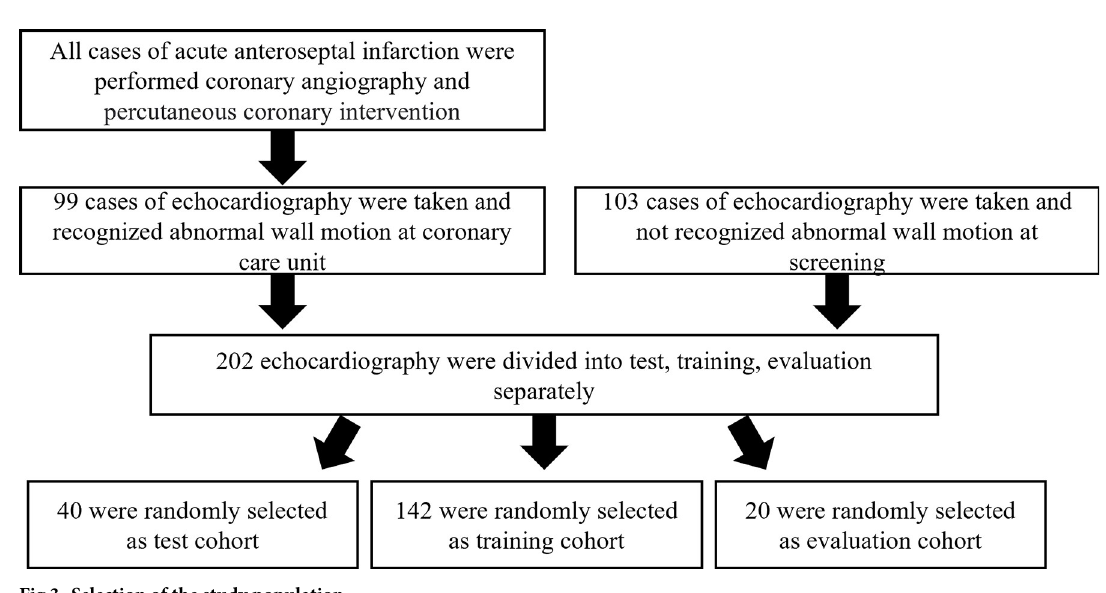
Fig 3. Selection of the study